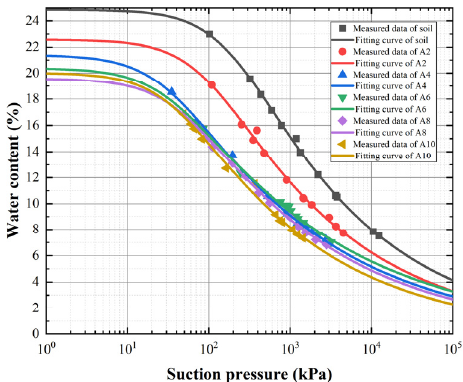
Figure 7. Changes in SWCCs under different action times of SMS-A.